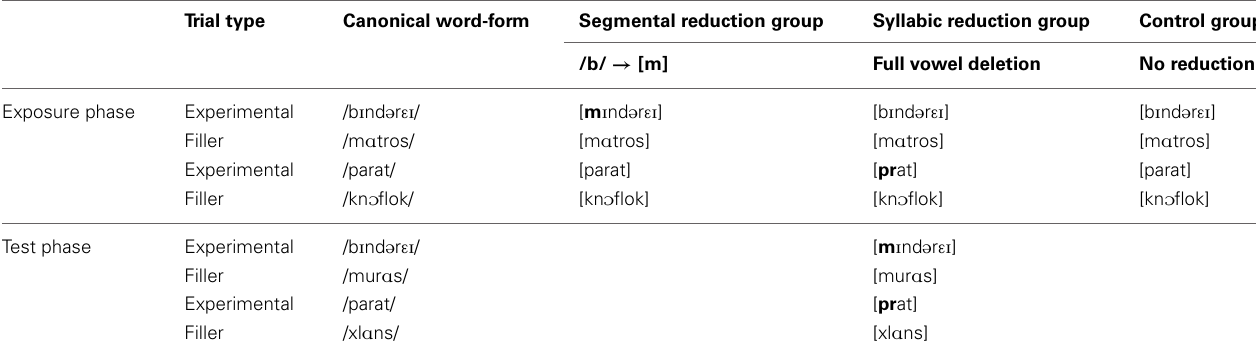
Table 1 | Experimental design and types of stimuli in Experiments 1 and